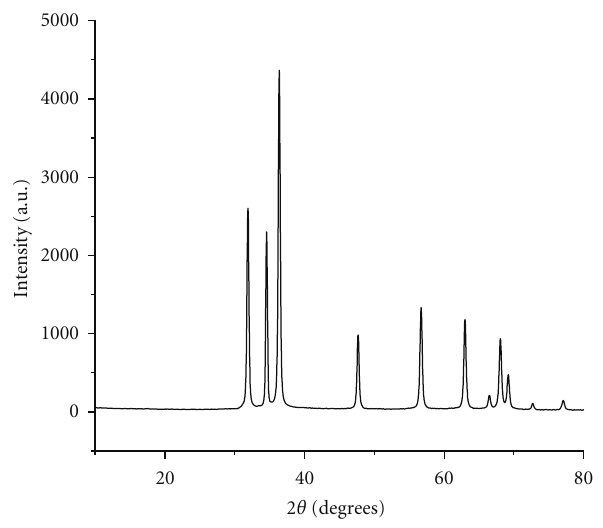
Figure 1: XRD pattern of ZnO NPs.